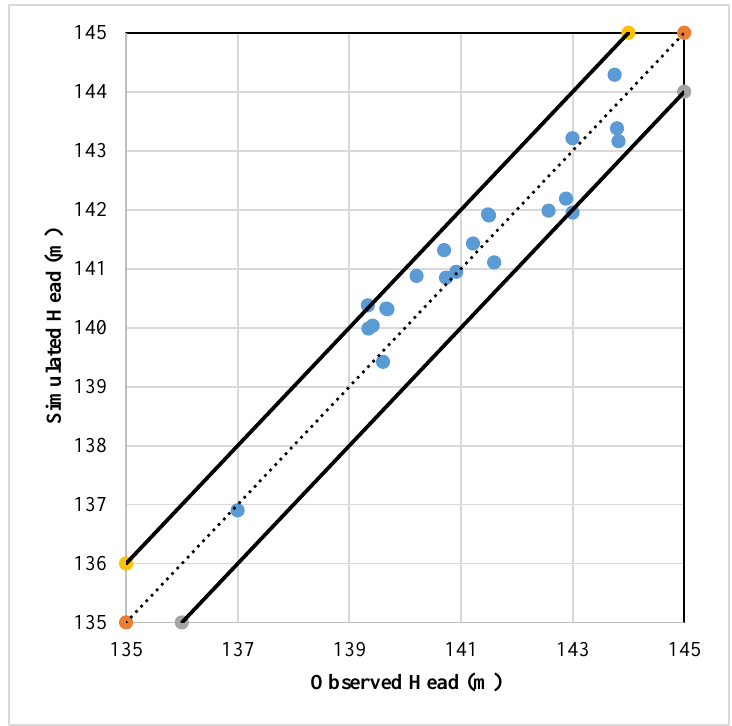
Figure 5. Model Calibration Graph.